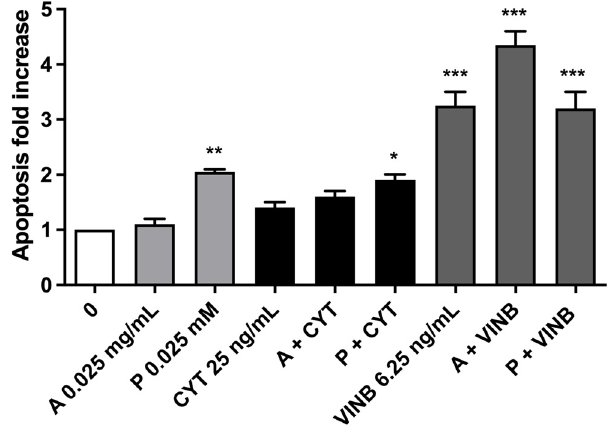
Figure 10. Apoptosis fold increase on TK6 cells after 26 h treatments with A. leucotrichus (A) or perillaldehyde (P) at the indicated concentrations in the presence or absence of CYT (clastogen) or VINB (aneugen) compared to the untreated cultures (0). * p < 0.05 vs. 0; ** p < 0.01 vs. 0; *** p < 0.001 vs. 0.